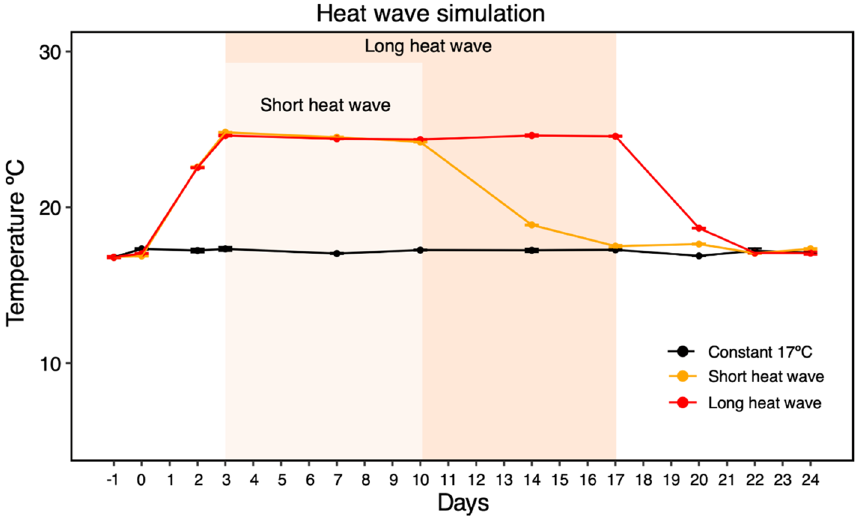
Figure 1. Details of the three temperature experimental conditions, with the measured temperature (mean and standard deviation) during the experimental procedure, highlighting the heatwave simulation periods for each temperature treatment. Graph done with ggplot2 from R software (https:// ggplo t2. tidyv erse. org) and shadow included with INKSCAPE (https:// inksc ape.